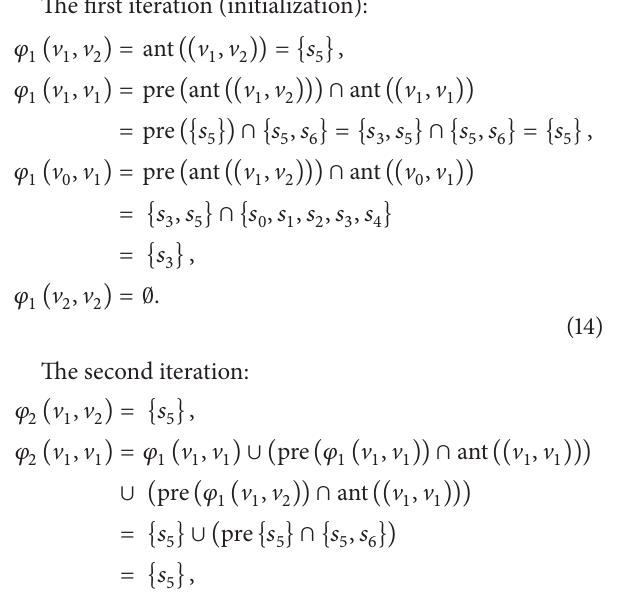
Figure 2: An assertion graph.